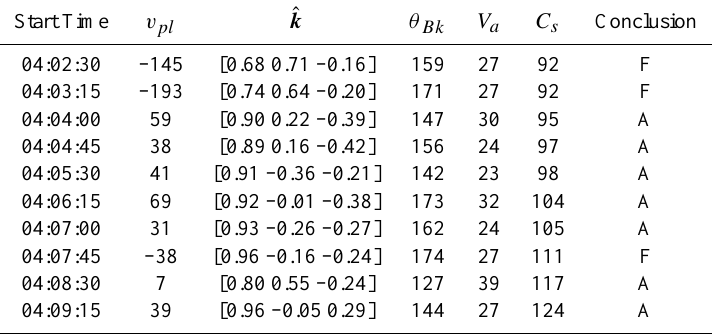
Table 1. Results of the cross-correlation wave analysis technique applied to ten consecutive 45s intervals between 04:02:30 UT and 04:10:00 UT. v pl is the phase speed in the plasma